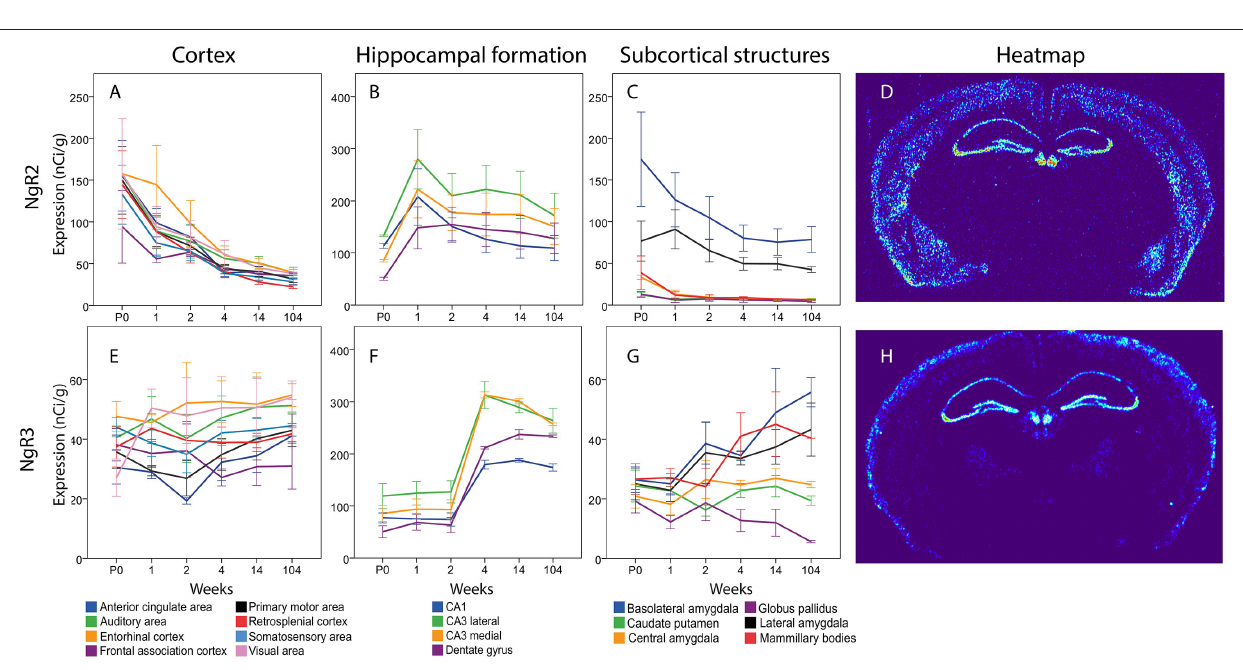
2 weeks, both lateral and medial CA3 also had a